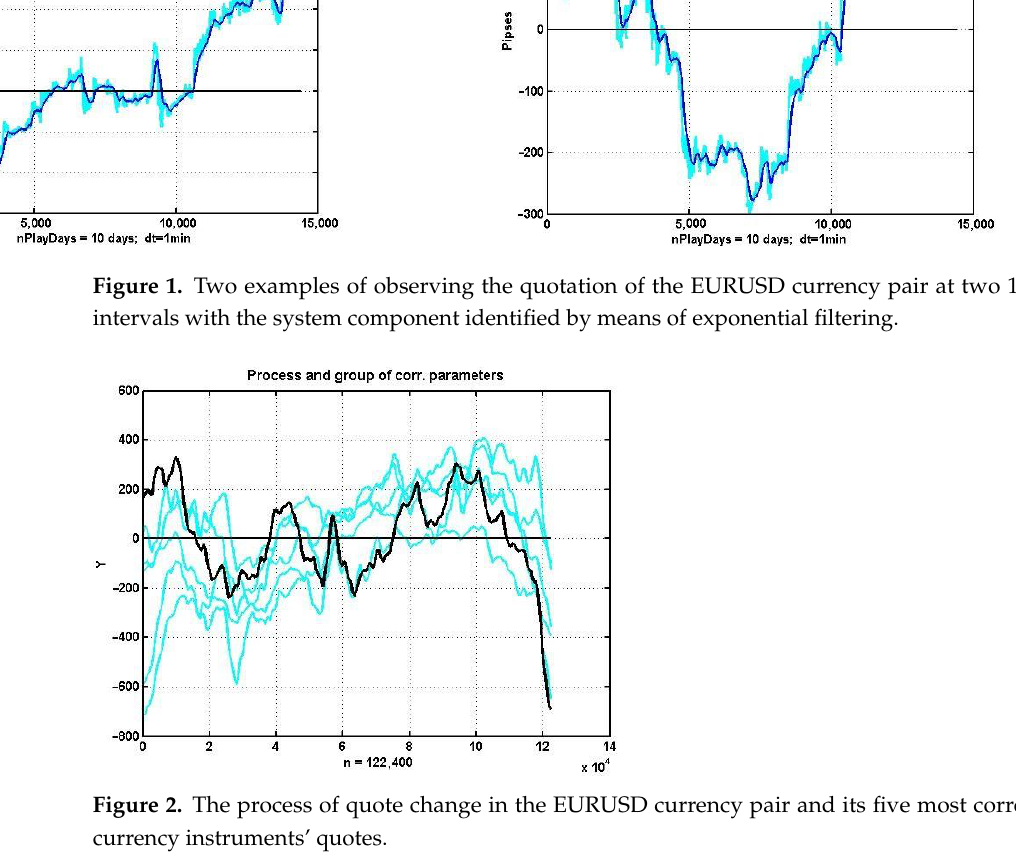
Figure 2. The process of quote change in the EURUSD currency pair and its five most correlated currency instruments’ quotes.